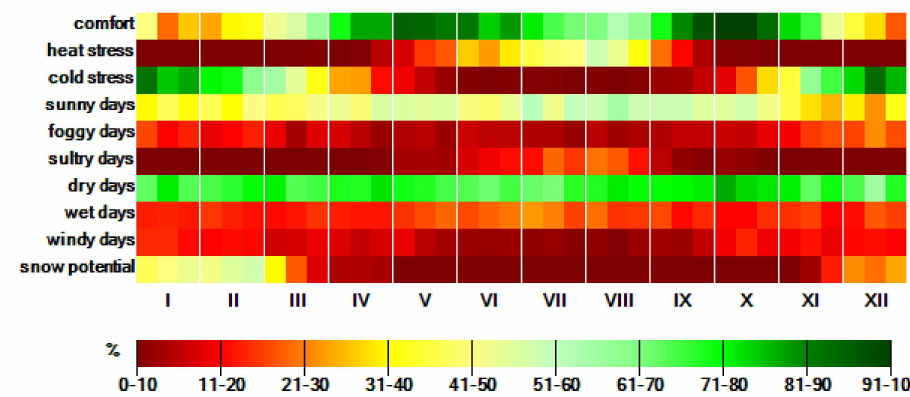
Figure 9. CTIS for Długopole-Zdr ó j in 1971–2010.